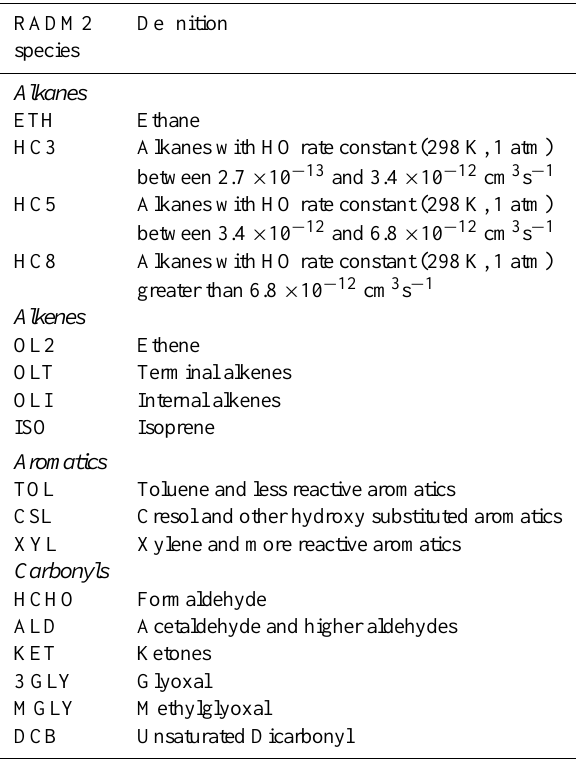
Table 4. VOCs of the RADM2 mechanism (according to Stockwell et al., 1990).